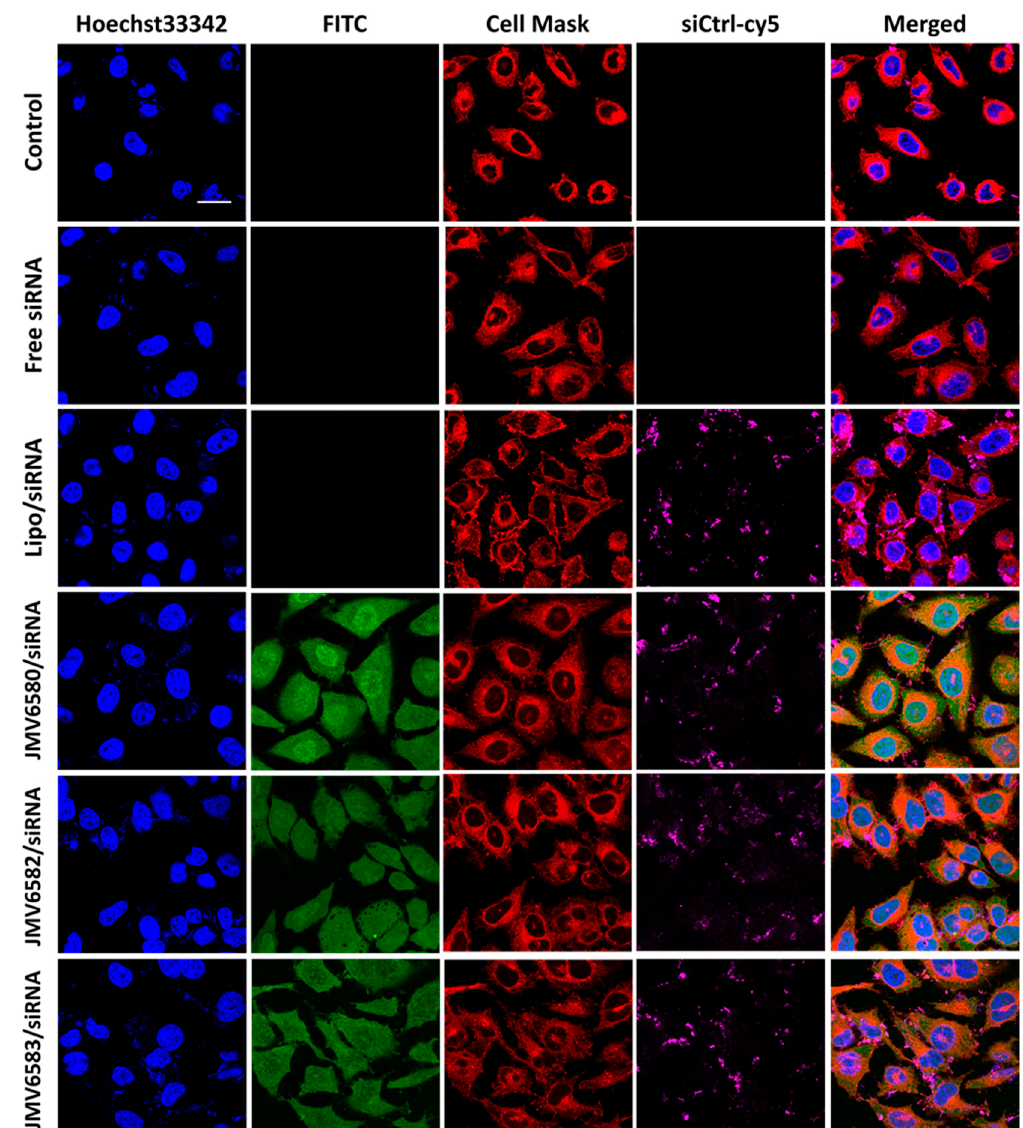
Figure 4. Cellular uptake of stapled peptides / siRNA complexes in HeLa cells visualized by fluorescence confocal microscopy. From the top to the bottom respectively: Untreated cells, cells incubated with 100 nM of siCtrl-cy5, cells incubated with the lipofectamine / siCtrl-cy5 complex at 50 nM, and finally cells incubated with the complex formed between stapled peptides (JMV6580, JMV6582 and JMV6583 respectively) and siCtrl-cy5 (100 nM) at N / P = 2 for JMV6580 and JMV6583, and N / P = 5 for JMV6582. The blue fluorescence indicates the nuclei, stapled peptides appear in green color, cell mask appears in red color, siCtrl-cy5 appears in magenta color. Scale bar = 20 µ